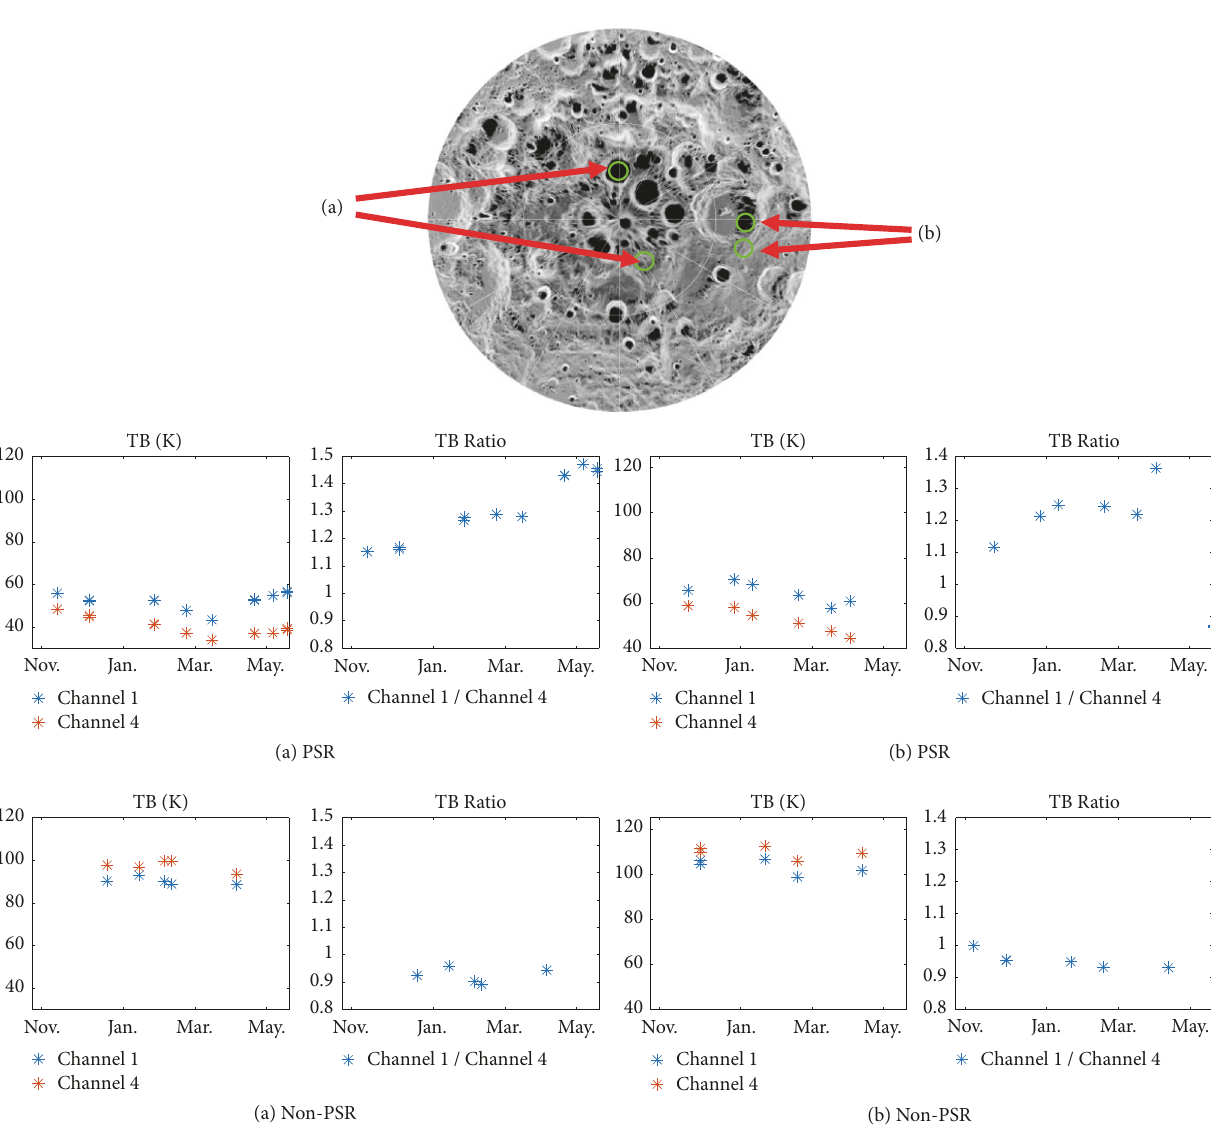
Figure 3: TB and TBR variations in Haworth Crater (PSR crater: -1.3 ∘ E, 87.5 ∘ S) and Non-PSR crater (150 ∘ E, 87.5 ∘ S) in the same latitude of Polar Regions; (b): TB and TBR variations in Amundsen Crater (PSR crater: 92.3 ∘ E, 83.7 ∘ S) and Non-PSR crater (105 ∘ E, 83.7 ∘ S) in the same latitude. The data is selected during the whole observation period. The green circles in the base map show the regions we selected. The base map is the Diviner annual maximum temperature map that varies from 30 K (black) to 345 K (white) in the Polar Regions